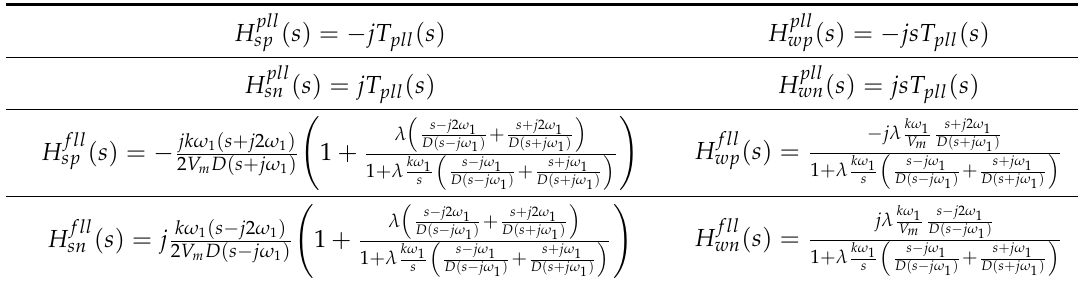
Table 2. Detailed expressions of the transfer functions in Equation (5) with different phase-locked loops (PLLs).